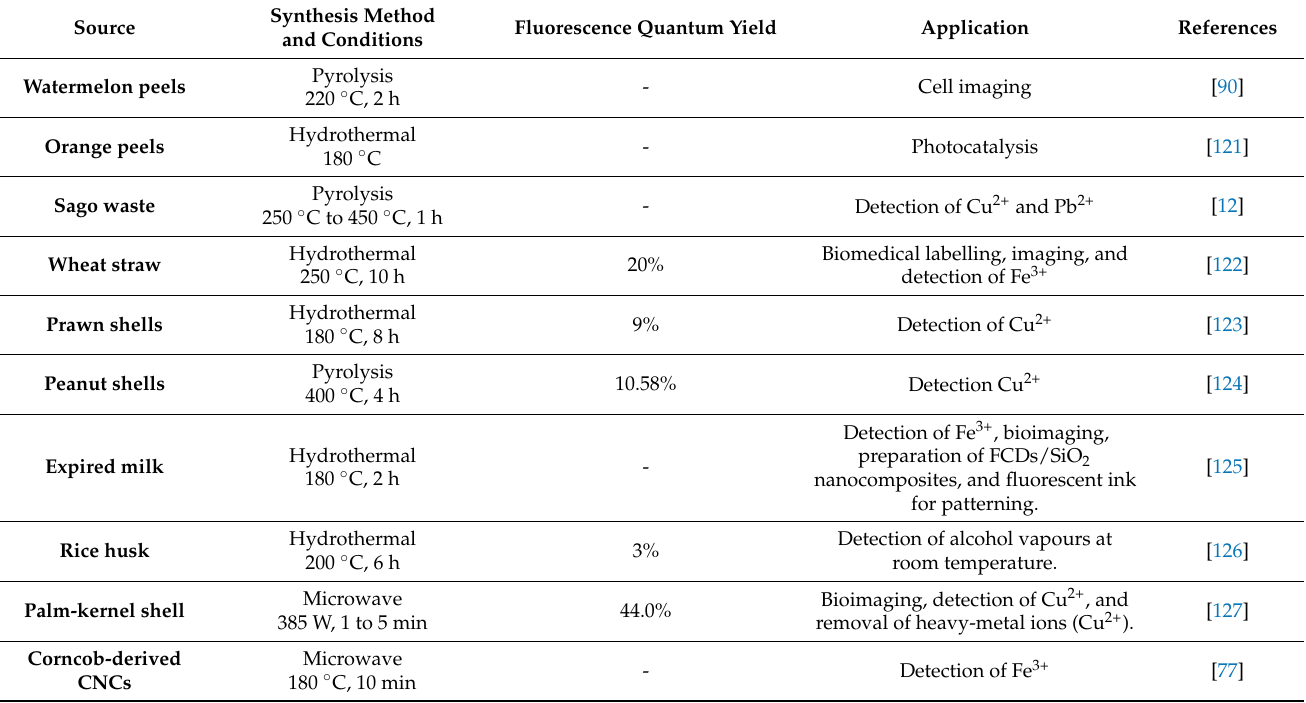
Table 3. Selected articles showing the fabrication, properties, and applications of CQDs using biomass waste as a